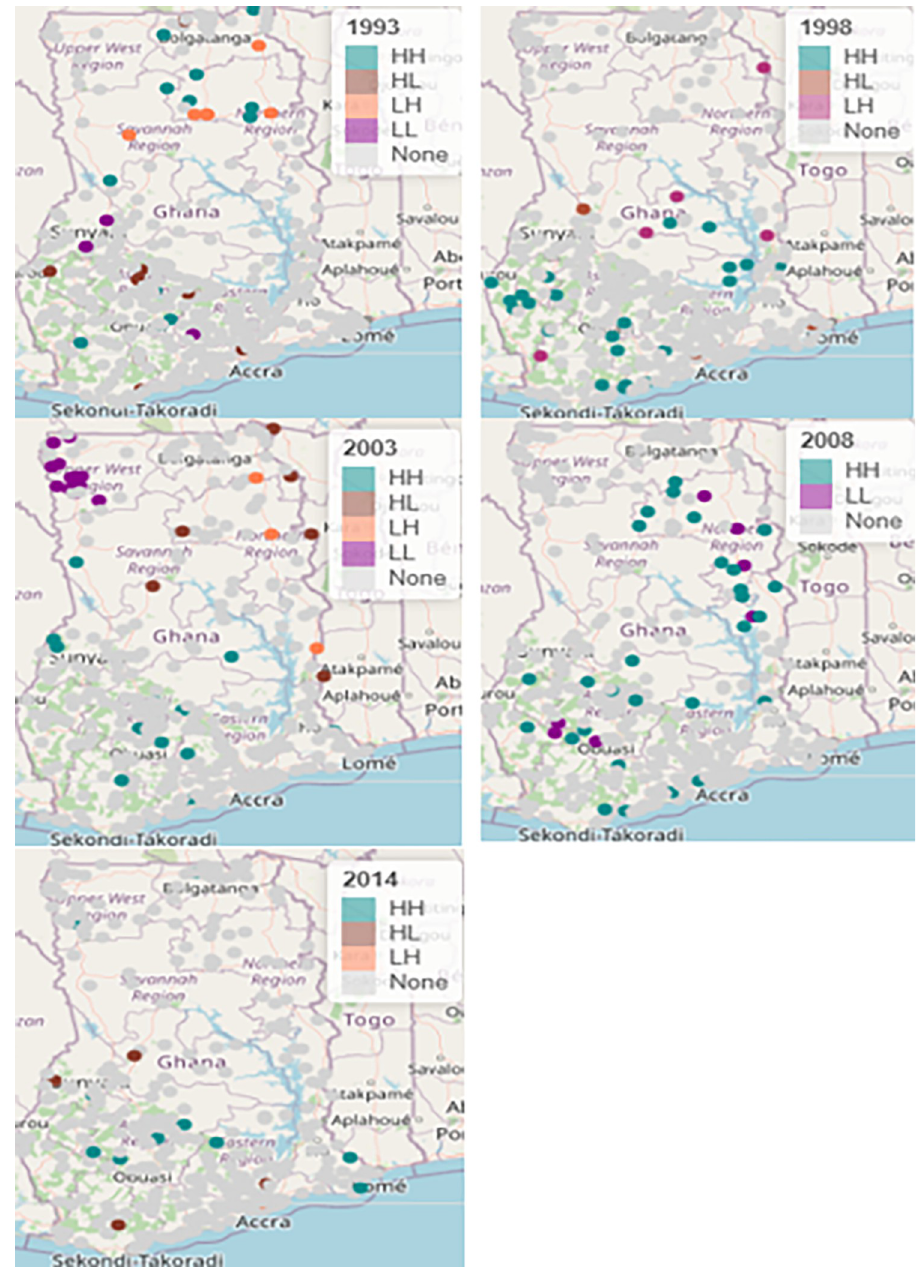
Fig 4. LISA Cluster map showing relative risk of neonatal mortality across GDHS clusters with associated geographical, individual and community factors, 1993–2014. Note: This map was produced by the authors. high spatial outliers, and non-significant spatial points. A GDHS cluster with a significantly high value of the relative risk of neonatal mortality surrounded by its neighbors with a signifi- cantly high relative risk of neonatal mortality were observed in Northern, Upper West and some part of Western and Ashanti regions respectively in 1993 giving rise to High-High clus- ters. Hot spots GDHS clusters were observed in Central, Western, Volta, Brong Ahafo, Eastern and Ashanti regions while a few spatial outliers (overdispersion) of risk of neonatal mortality